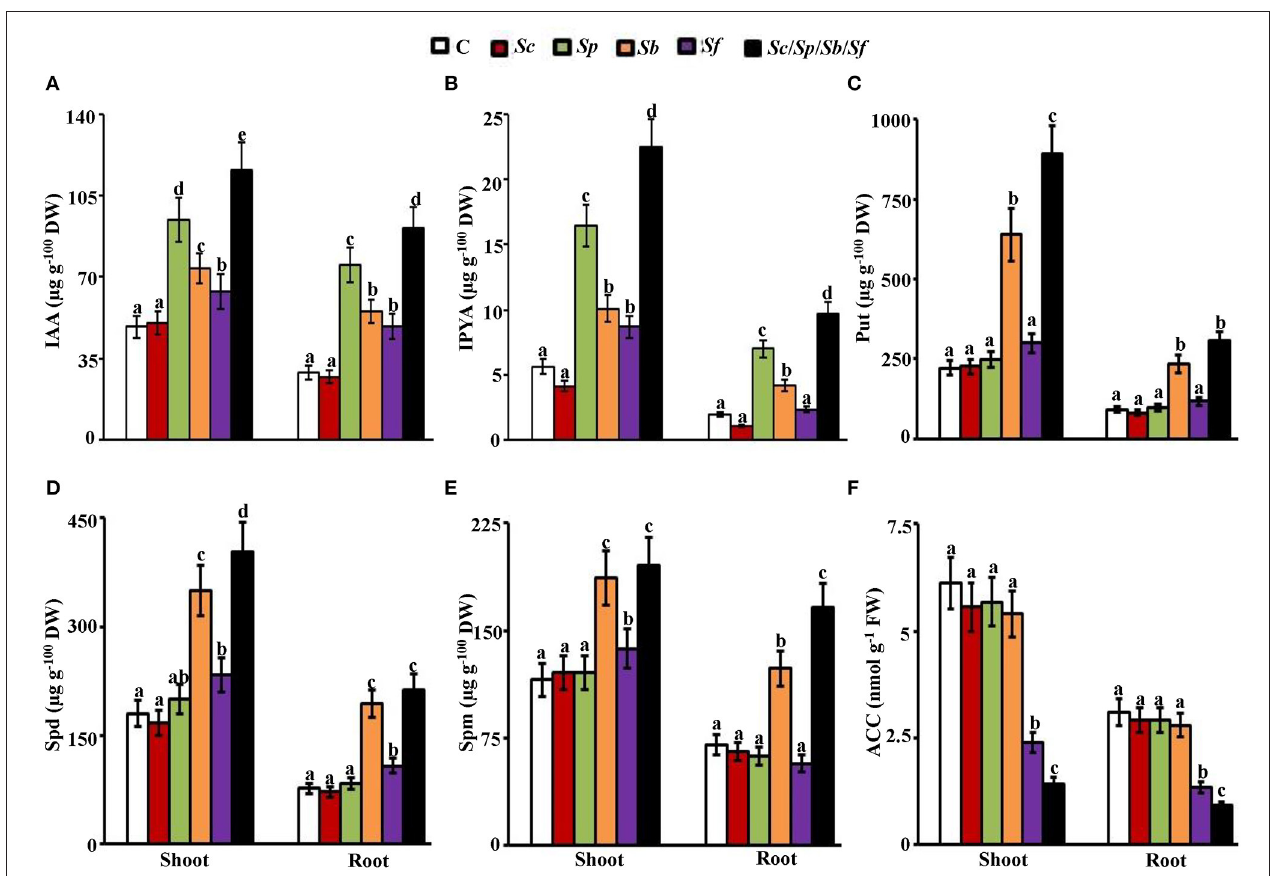
FIGURE 6 | Effect of actinobacterial isolates on auxins, PAs, and ACC content of mangrove tissues. In planta contents of (A) IAA; (B) IPYA; (C) Put; (D) Spd; (E) Spm; and (F) ACC in mangrove shoot and root tissues after treatment with control, Sc , Sp , Sb , Sf , and Sc / Sp / Sb / Sf . Mangrove seedlings were grown in an evaporative-cooled greenhouse (28 ± 2 ◦ C). The values for each sampling are the means of 16 replicates from two independent experiments. Mean values followed by different letters are significantly ( p < 0.05) different from each other according to Fisher’s Protected LSD Test. Bars represent SE. In planta contents of IAA, IPYA, Put, Spd, Spm, and ACC were measured at 9 months post planting the propagules of mangrove. DW/FW, dry/fresh weight; C, control (autoclaved non-inoculated oat bran); Sc , P-solubilizing isolate #2 ( Streptomyces coelicoflavus UAE2); Sp , auxin-producing isolate #15 ( Streptomyces polychromogenes UAE1); Sb , PAs-producing isolate #6 ( Streptomyces bacillaris UAE1); Sf , ACCD-producing isolate #37 ( Streptomyces ferrugineus UAE1); Sc/Sp/Sb/Sf, consortium of the four isolates; P, phosphorus; IAA, indole-3-acetic acid; IPYA, indole-3-pyruvic acid; PAs, polyamines; Put, putrescine; Spd, spermidine, Spm, spermine;